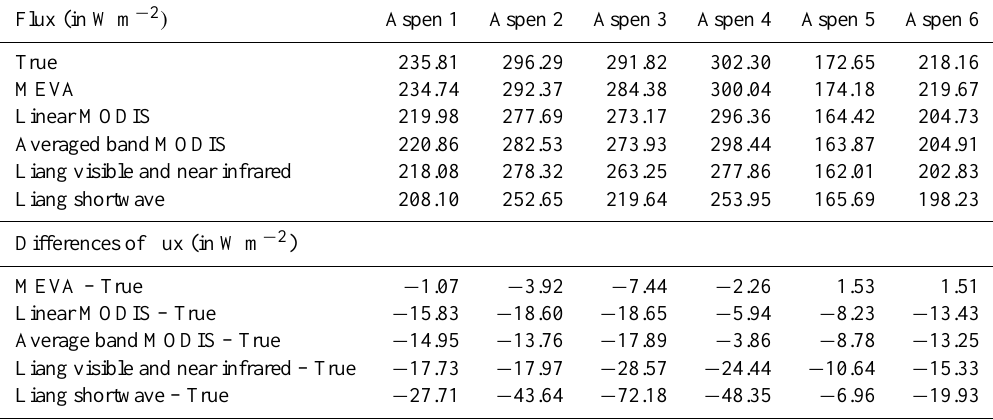
Table 4. The calculated integration of the outgoing solar flux (in Wm − 2 ; from 0.3 to 2.5µm) at TOA over aspen surface. Other parameters used in the calculation include AOD (at 0.55µm) of 0.32; SSA (at 0.55µm) of 0.89; and SZA of 30 degrees. Bold numbers represent the difference of the flux associated with applying different approaches to estimate the reflectance spectrum.